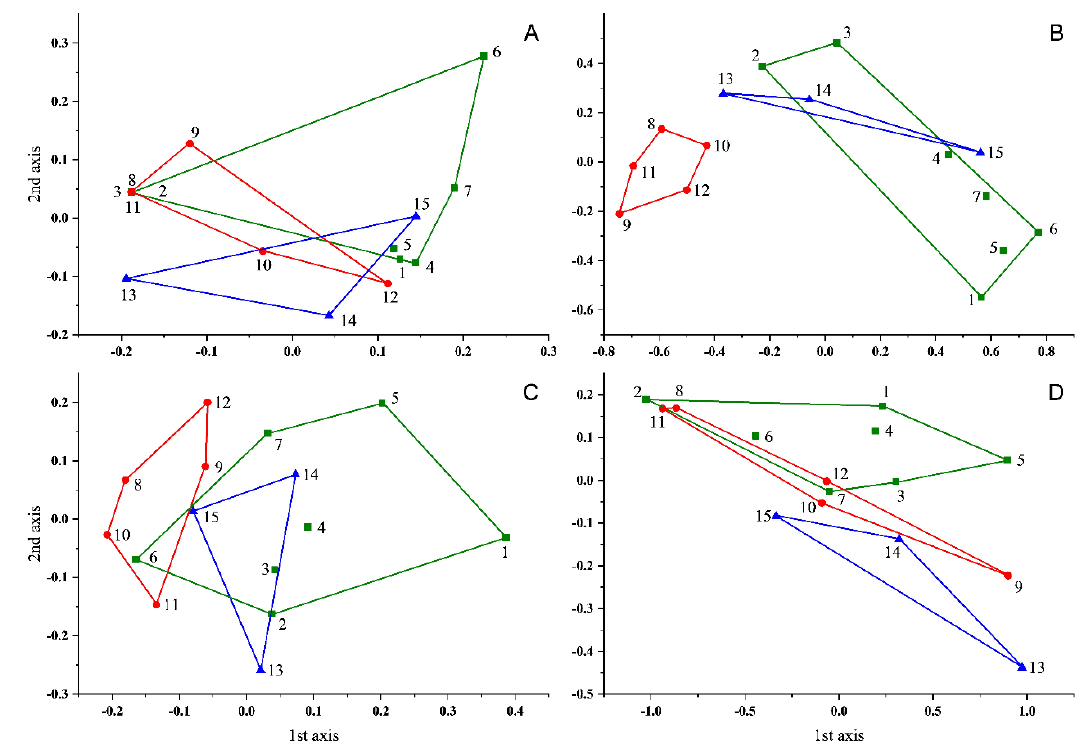
Figure 4. Non-metric multidimensional scaling (NMDS) of the Cladocera communities based on the Rogers–Tanimoto index (binary) and Bray–Curtis index (abundance) of the Cladocera communities. Numbers/symbols represent the samples. 1–7: protected area, 8–12: biomanipulated area, 13–15: recreational area. ( A ) Contemporary Cladocera communities, Bray–Curtis dissimilarity (stress = 0.3813); ( B ) contemporary Cladocera communities, Rogers–Tanimoto similarity (stress = 0.2568); ( C ) subfossil Cladocera communities, Rogers–Tanimoto similarity (stress = 0.2732); ( D ) subfossil